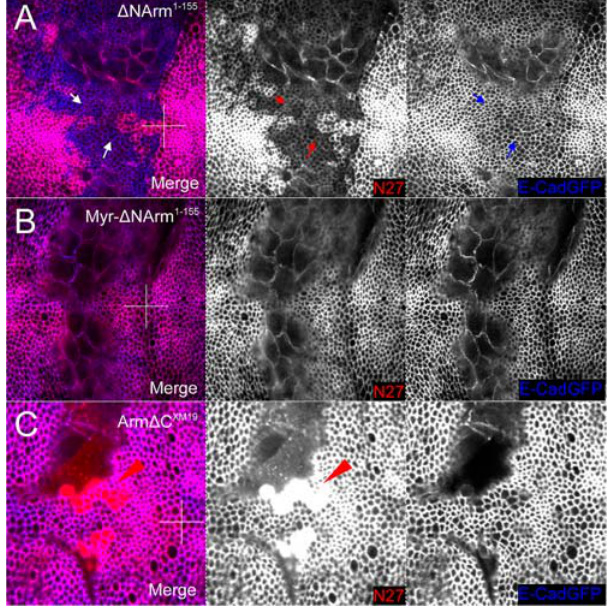
Figure 11. E-Cadherin levels change in the cytoplasm or basolateral membrane in response to changes in levels of endogenous Armadillo protein upon N-terminal deletion mutant overexpression. (A) E-Cadherin levels appear reduced in the domain of expression where endogenous Armadillo is excluded. Fewer puncta are also apparent relative to neighbouring wild type tissue upon overexpression of the D NArm 1–155 . (B) No change is evident in E-Cadherin levels when the membrane tethered Myr- D NArm 1–155 form is overexpressed. (C) E-Cadherin levels are reduced in the domain of Arm D C XM19 expression, and puncta are lacking. This is accompanied by an increase in the number of N27-postive puncta (red circles), representing endogenous or C-terminally truncated forms of Armadillo. There is also less E-cadherin associated with the anterior stripe, where endogenous Armadillo and E-cadherin perfectly colocalise under wild type conditions (red arrows). Note that in the wing disc in (C) only the dorsal aspect is shown, while (A) and (B) are show the intersection of the A/P and D/V boundaries.